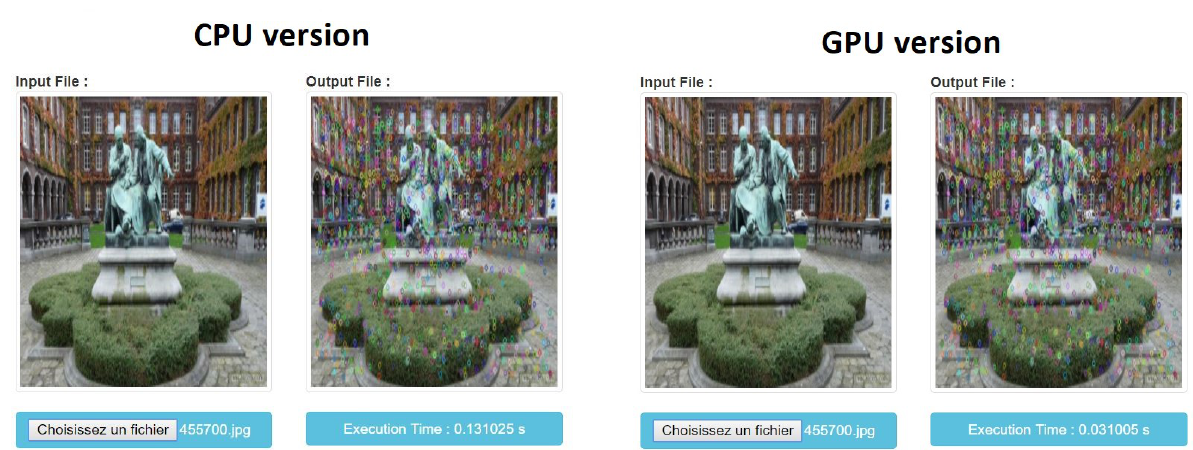
Figure 4 | Illustration of our cloud-based SURF descriptor on CPU and